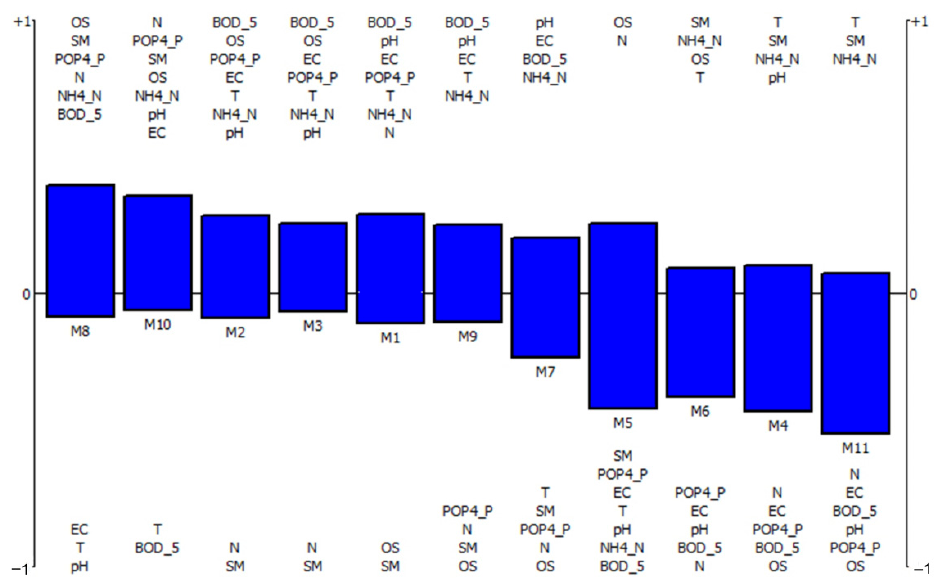
Figure 2. Classified view of the PROMETHEE II ranking.